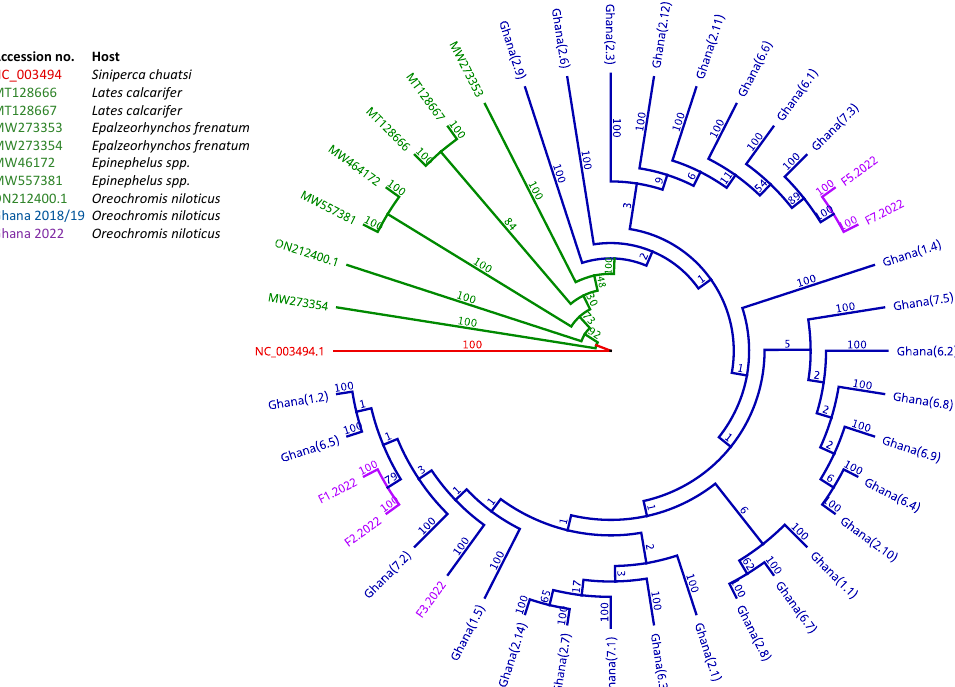
Figure 3. Phylogeny of whole ISKNV genomes of 36 samples collected from Lake Volta (2019 in blue and 2022 in purple) with whole ISKNV genomes reported in the GenBank, in green (listed in Supplementary Table S2), using MAFFT [32] with the bootstrapped branch support. The tree was rooted to the ISKNV reference genome (NC_003494), shown in red. Numbers in brackets after the Ghana samples from this study are in the format < farm identifier >.< sample identifier >.